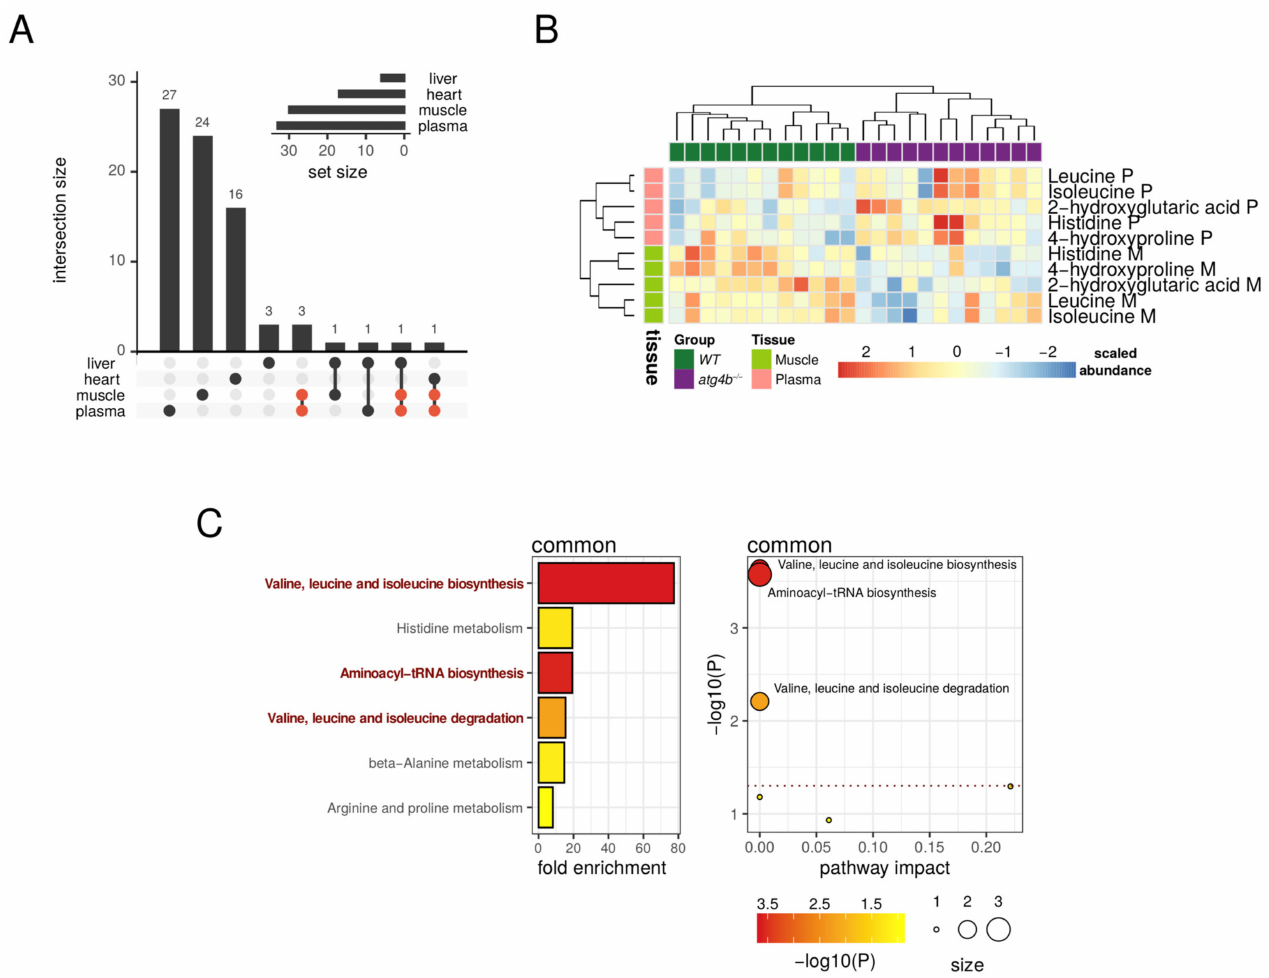
Figure 7. Oppositely targeted metabolites in plasma and muscle. ( A ) Upset plot showing the intersections of the sets of significantly altered metabolites found for each tissue. The five common metabolites between plasma and muscle are highlighted in red. ( B ) Heatmap describing the row-scaled log2 quantification levels of the five common metabolites detected as significantly altered in both plasma and muscle tissues. ( C ) On the left, the bar plot describes altered metabolic pathways with detected fold-enrichment, colored by significance ( − log10 of p -value) for the five common metabolites detected as significantly altered in both plasma and muscle tissues. On the right, the scatterplot describes the pathway impact, size, and significance of the detected metabolic pathways. The horizontal dotted line in the scatterplot marks the 0.05 p -value threshold (unadjusted). Representative significant (unadjusted p -value < 0.05) pathways are highlighted in the bar plot and labeled in the